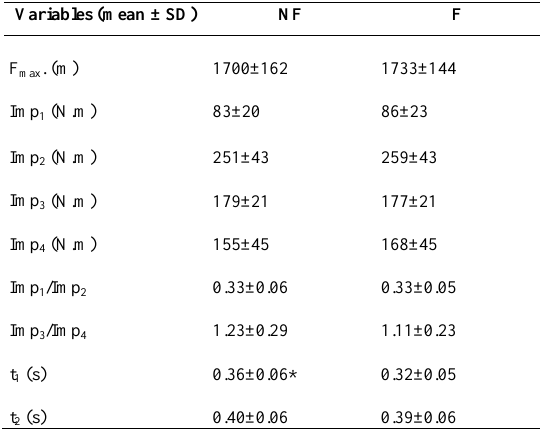
Table 2. The table shows the correlation coefficients between the Table 4. Results of the paired samples t test for the H maximum height reached in CMJ (H ) before the fatigue protocol and some variables defined in the study. Asterisks in the second column max (NF) and with muscular fatigue (F), and the time and temporal relations indicates variables which showed significant differences in one condition considered in the analysis. The asterisks (*) indicate the existence of relative to the other ( p significant correlations ( p <0.05).